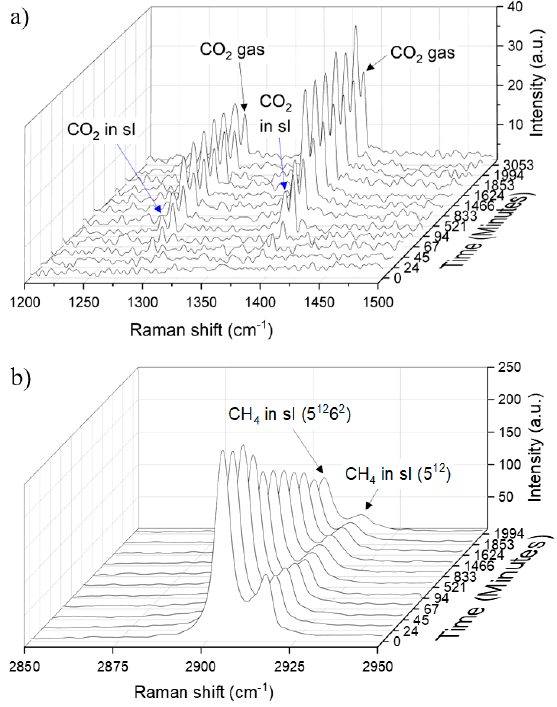
Figure 4. Real-time Raman spectra monitoring of the ( a ) CO 2 hydrate and ( b ) CH 4 hydrate for changes in the solid phase as a result of the shift in gas phase from CH 4 gas to CO 2 gas. Blue arrows in Figure 4a point out the first appearance of Raman bands at 1277 cm − 1 and 1382 cm − 1 for the CO 2 hydrate after around 500 min. The time axes are displayed value-independent.